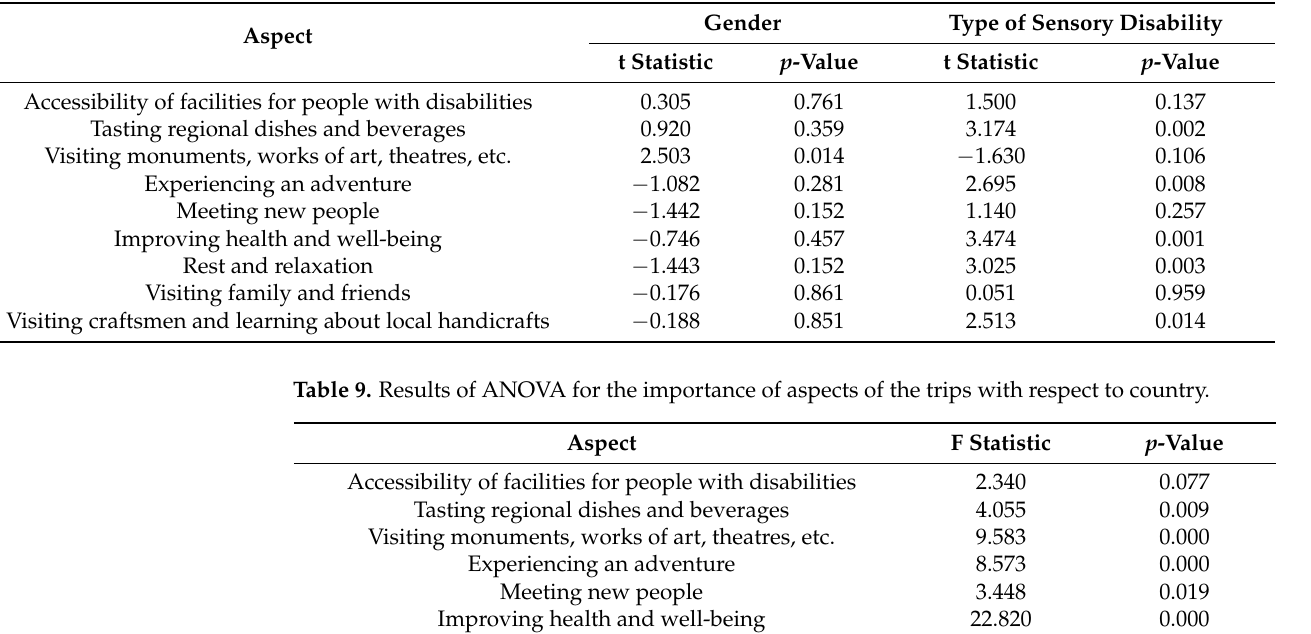
Table 8. Results of t-tests for the importance of aspects of the trips with respect to gender and type of sensory disability.